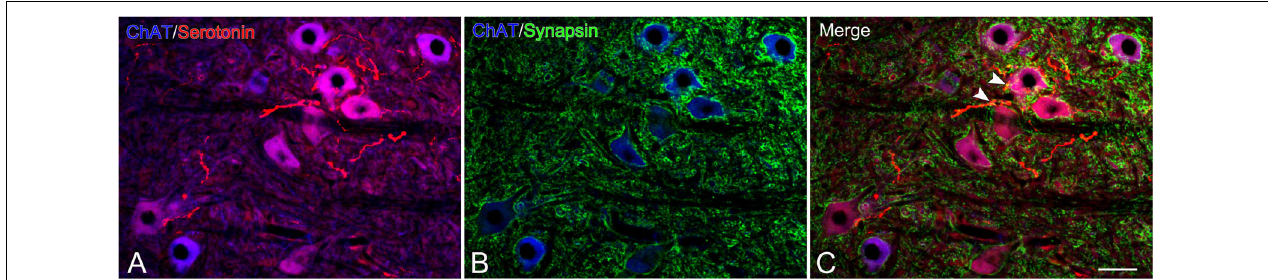
FIGURE 8 | Images of immunohistochemistry for synapsin I (green), ChAT (converted to blue), and 5-HT (red) in the L5 ventral horn of rats with ChABC administration at 8 weeks after CST. Double-labeled image of ChAT and 5-HT (A) , ChAT and synapsin I (B) , and merged images (C) . Arrowheads in (C) indicate nerve terminals doubly positive for 5-HT and synapsin I on motoneurons. Scale bars = 50 µ m.